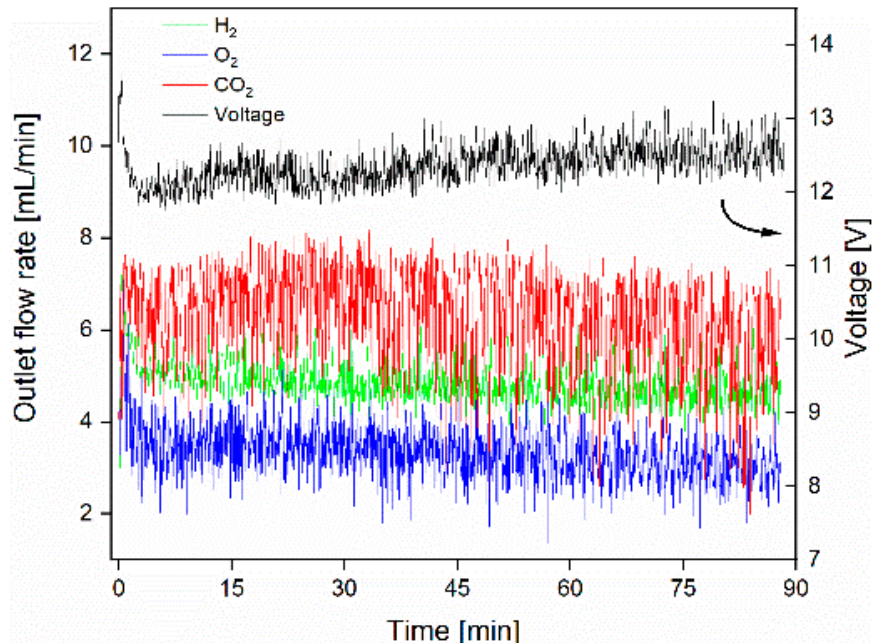
Figure 1. CO 2 , O 2 and H 2 outlet flows (left axis) and measured voltage (right axis) in a typical experiment carried out with the capture and release unit (experimental conditions: J = 100 mA/cm 2 , Q inlet = 20 mL/min, Q pump = 1 mL/min, CO 2 /N 2 ratio = 100%/0%).